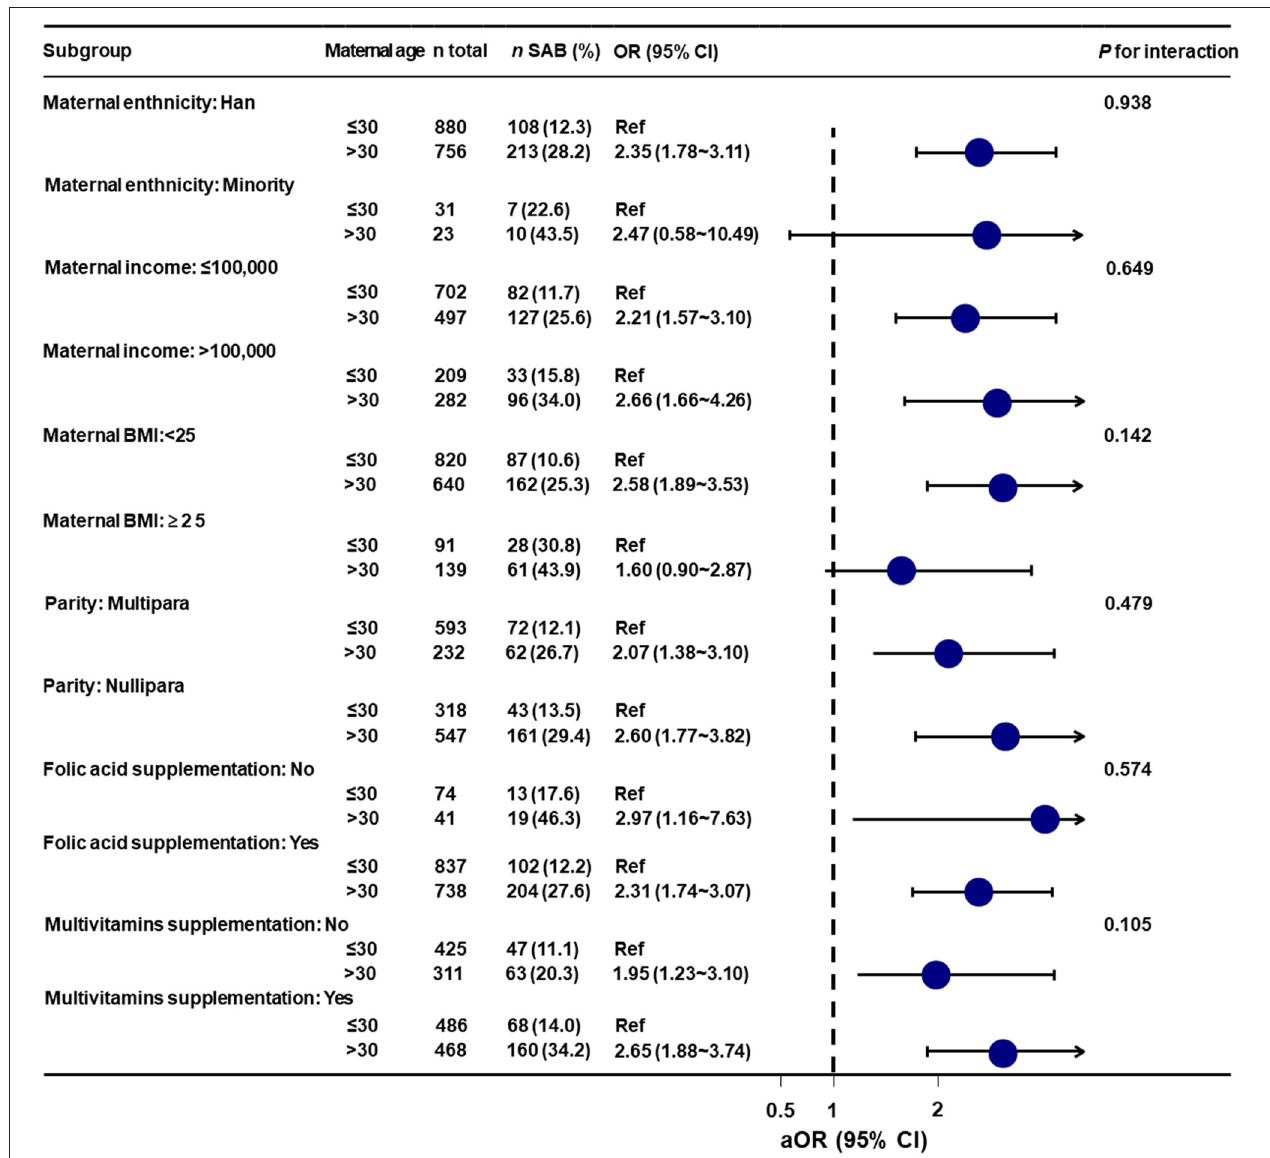
FIGURE 3 | Stratified analyses of the association between maternal age and spontaneous abortion. aOR, adjusted odds ratio; Ref, reference; BMI, body mass index; SAB, spontaneous abortion; CI, confidence interval. Data were fit by a logistic regression model based on restricted cubic splines. Maternal age was entered as continuous variable. Data were adjusted for maternal ethnicity, maternal education, maternal occupation, maternal income, maternal body mass index, parity, folic acid supplementation, multivitamins supplementation, and medication